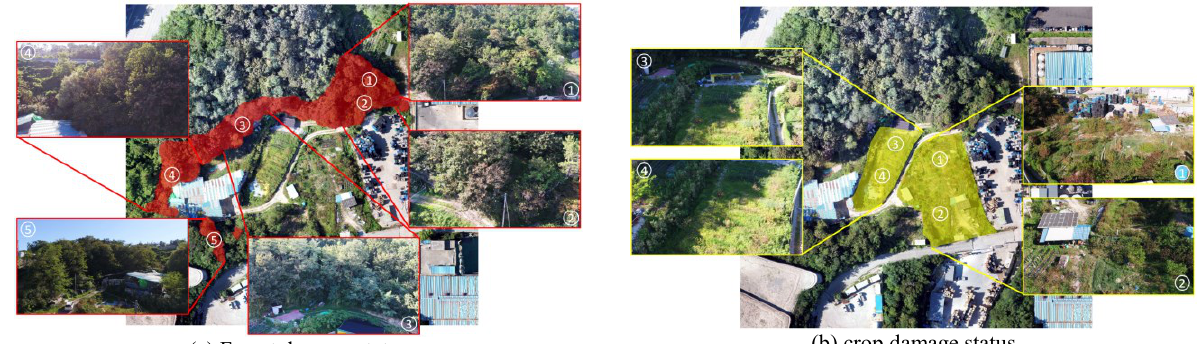
Figure 8 . Understanding damage status using high resolution photos at low altitude